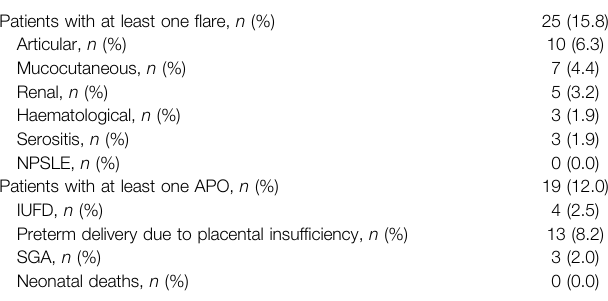
TABLE 1 | Maternal fl ares (2nd and 3rd trimester) and APO. Patients with at least one fl are, n (%) 25 (15.8) Articular, n (%)